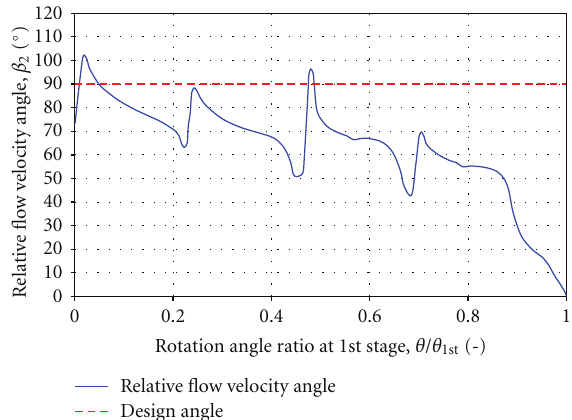
Figure 17: Relative flow velocity angles of 1st runner stage outlet along the normalized rotation sector at design conditions.